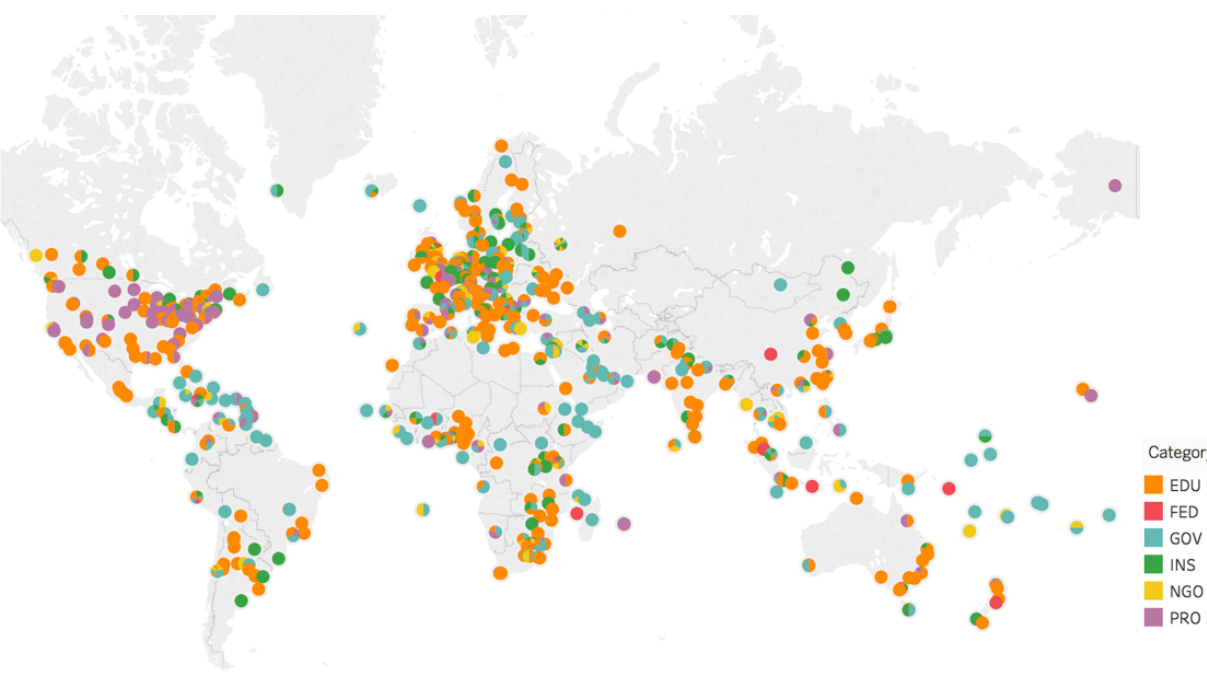
Figure 4. Distribution of EDUcational institutions, FEDerations, GOVernment agencies, INStitutes, NGOs and PROfessional organisations. Source: Authors based on